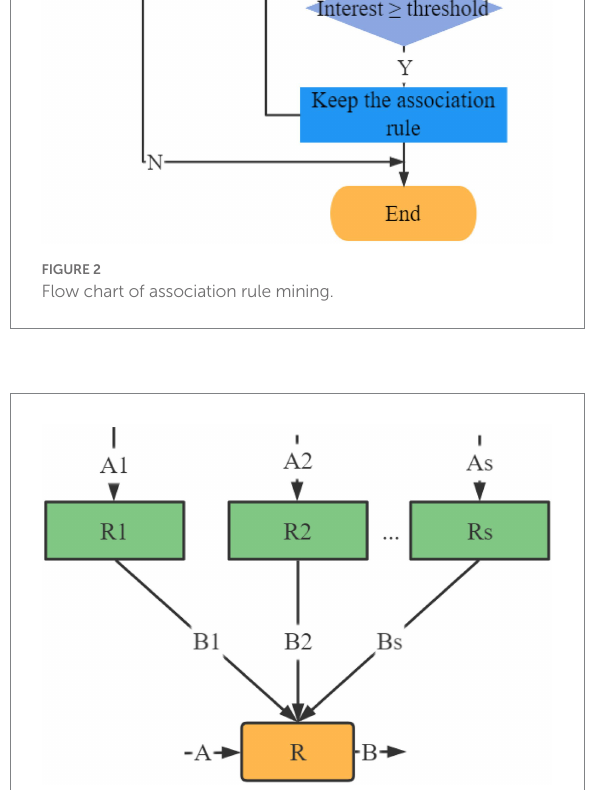
FIGURE 3 Two-level evaluation